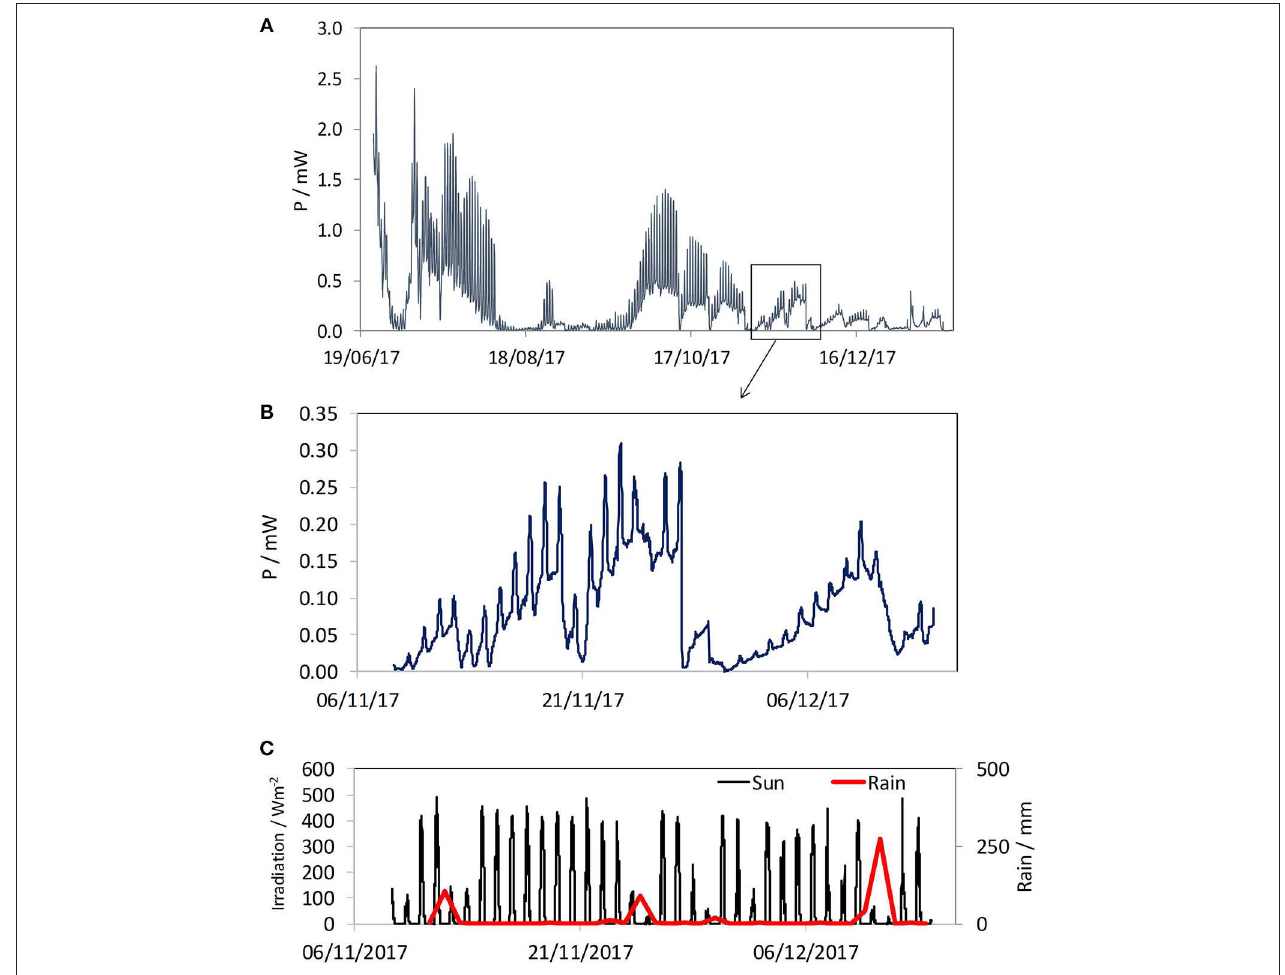
FIGURE 6 | Power trend of six Flat-small MFCs (10 × 13cm) with shortened anodes (Carimate WWTP) (A) . A detail of power trend between November and December 2017 (B) ; with meteorological measurements: sun irradiation and rain (C)